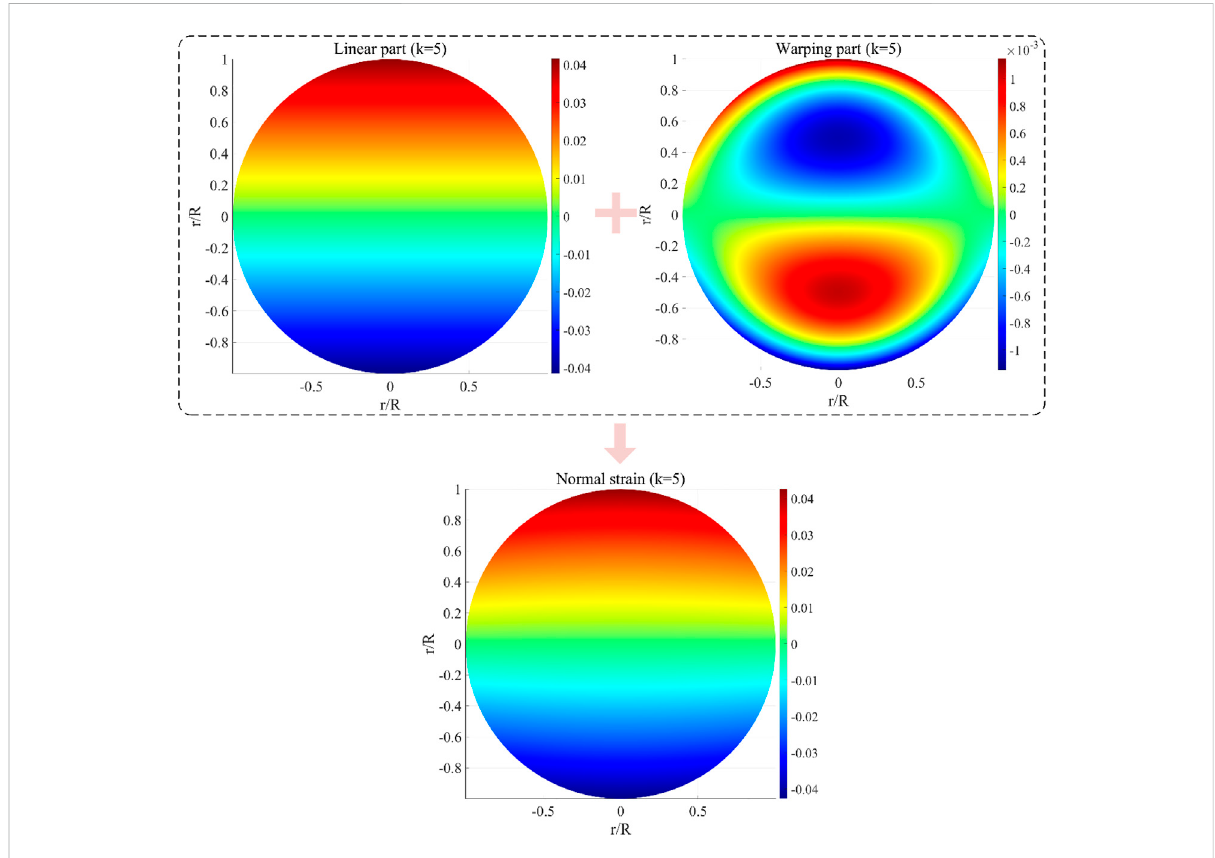
FIGURE 5 The normal strain and its decomposition for k =